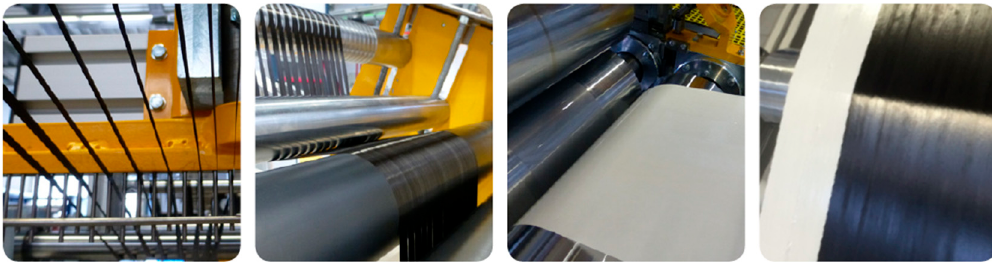
Figure 2. Single unidirectional-rovings, pre-fiber spreading unit, resin coating unit and final prepreg, respectively.